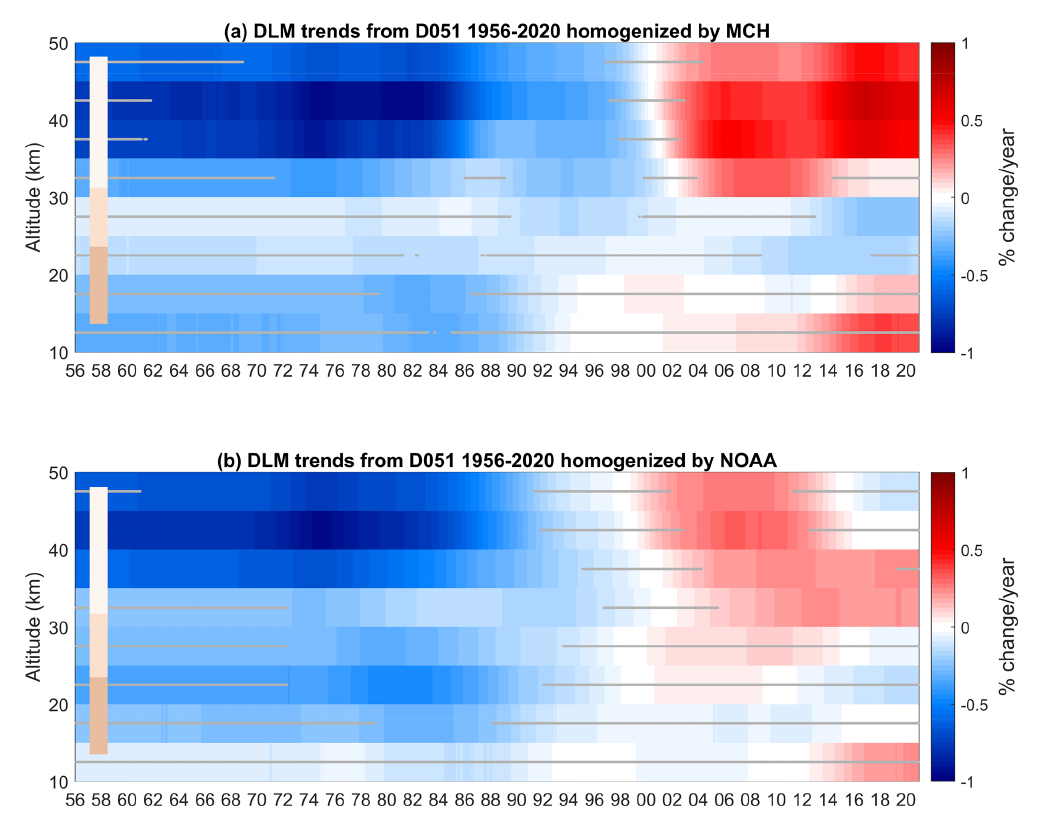
Figure 7. DLM trend estimates in percent per year of Dobson D051 1956–2020 from (a) MCH homogenized and (b) NOAA homogenized data records. Grey lines indicate trend estimates nonsignificantly different from zero at the 95% confidence level. The beige bars indicate the lower, middle and upper stratospheric